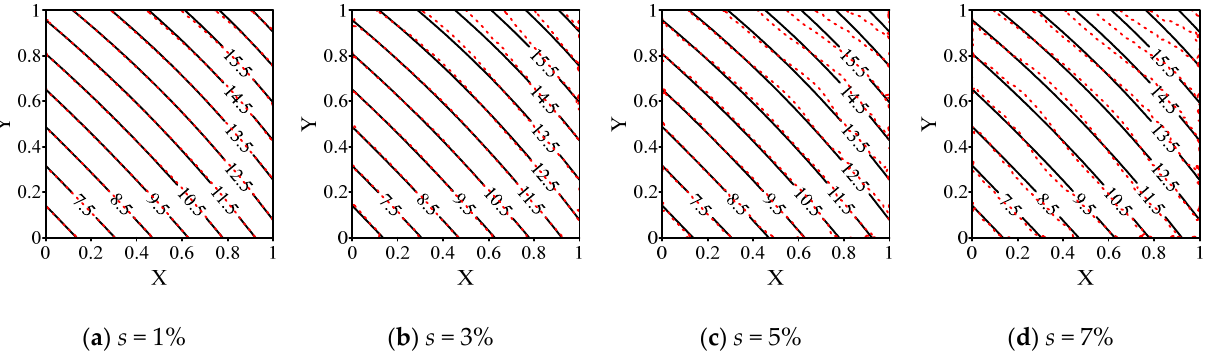
Figure 4. The distribution of numerical (dashed curves) and analytical solutions (solid curves).